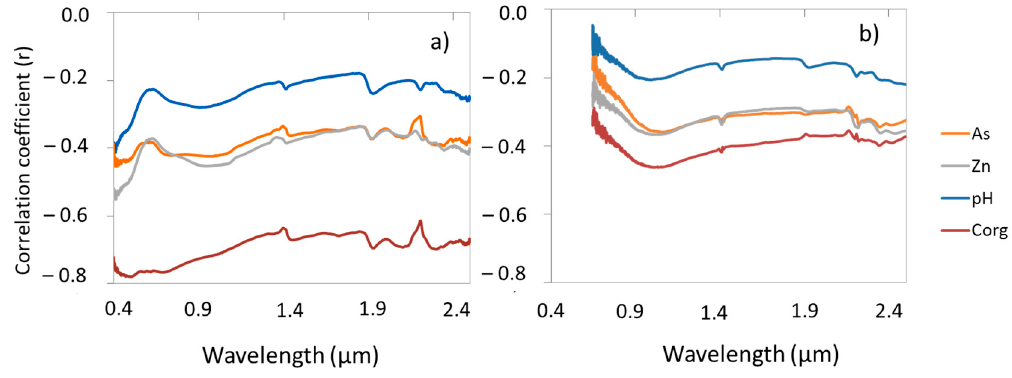
Figure 5. Spectral sensitivity calculated for ( a ) the ASD spectra (optical range 0.4–2.5 µm) and ( b ) the FSR spectrometer (optical range 0.6–2.5 µm) ( y -axes showing the Person’s correlation coefficients).